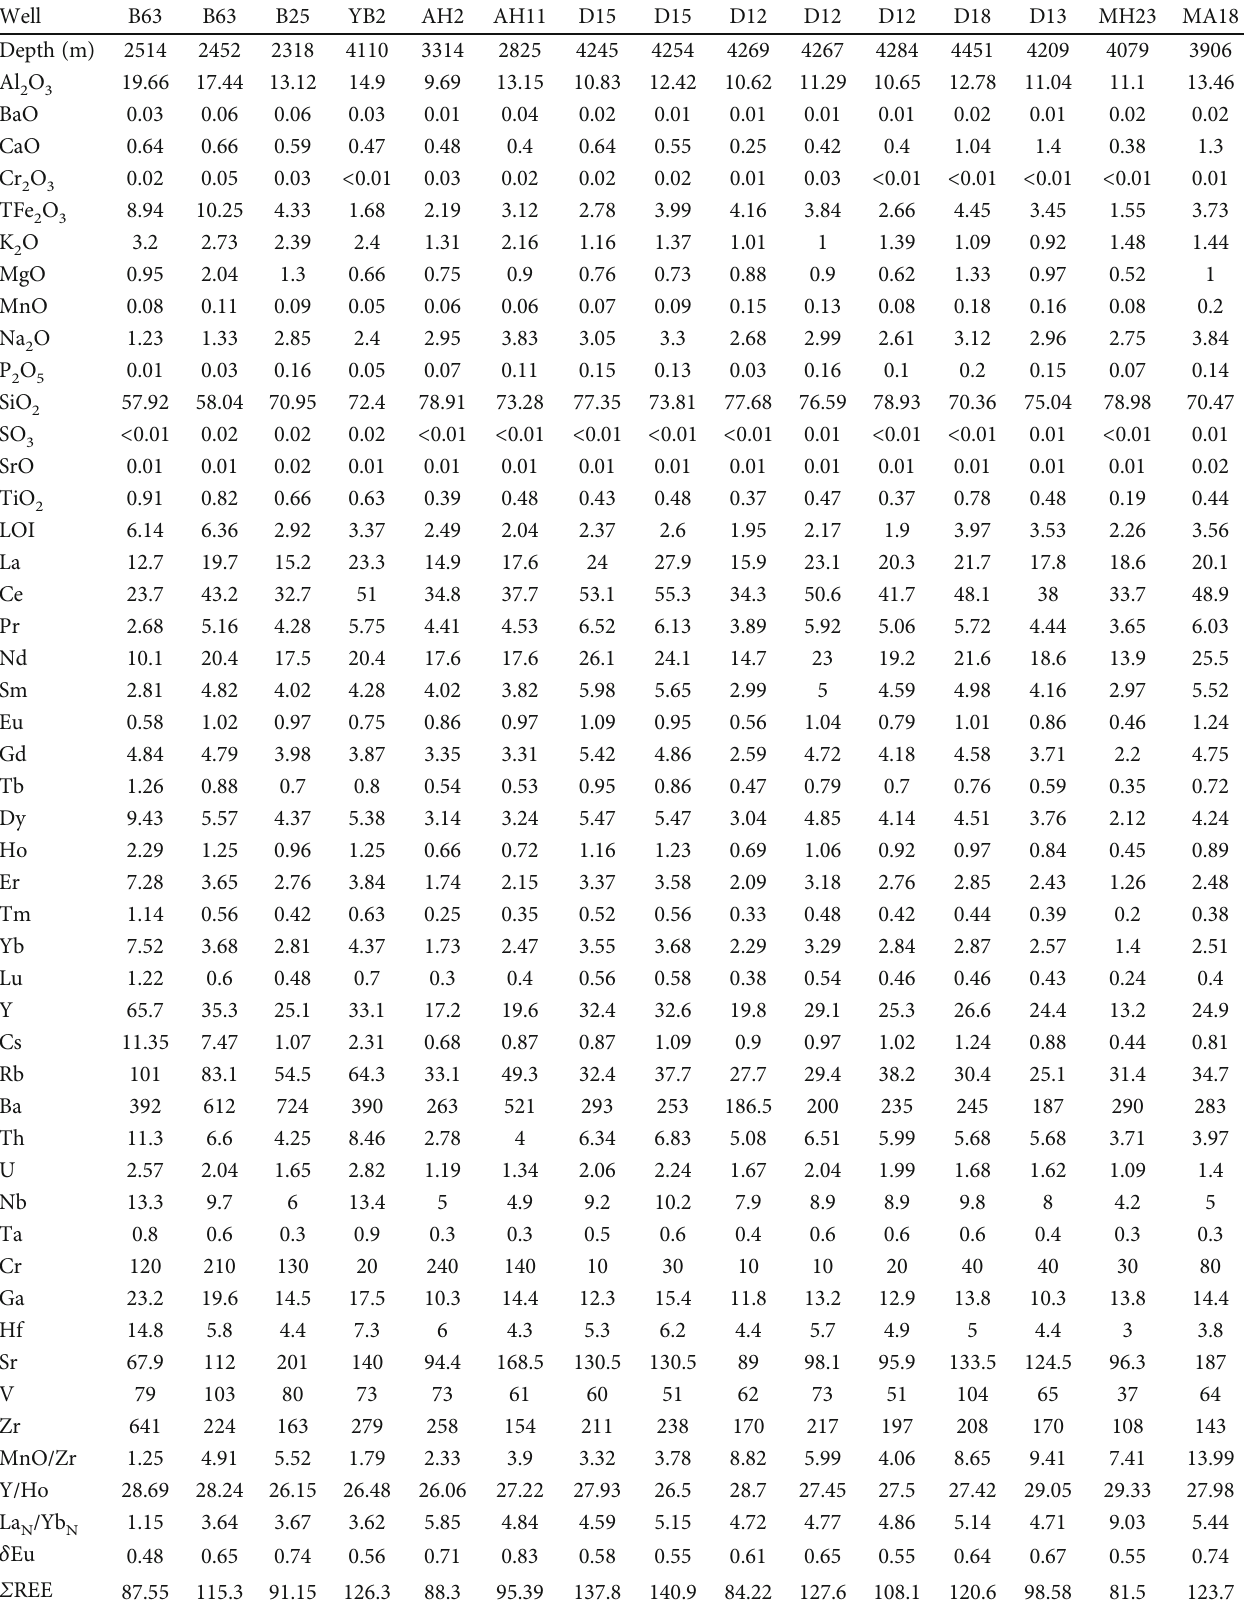
Table 4: Whole-rock major (in wt.%) and trace element (in ppm) data for samples from the Baikouquan Formation. Well